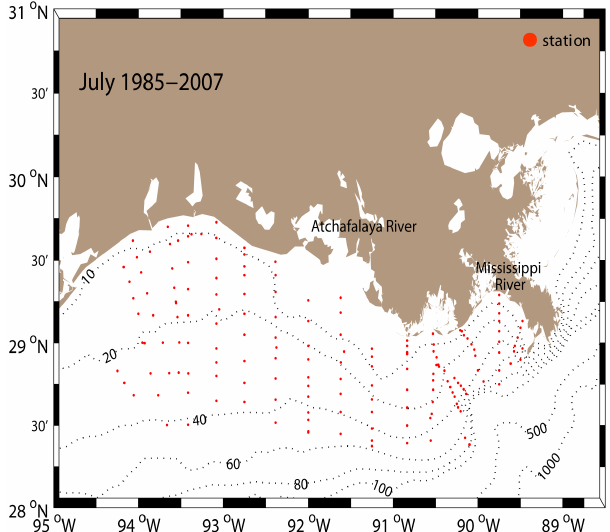
Fig. 1. The study area map showing the summer Texas–Louisiana shelf-wide cruise stations (red dots) during July 1985–2007 with the bathymetry contours (black dotted lines) in the northern Gulf of